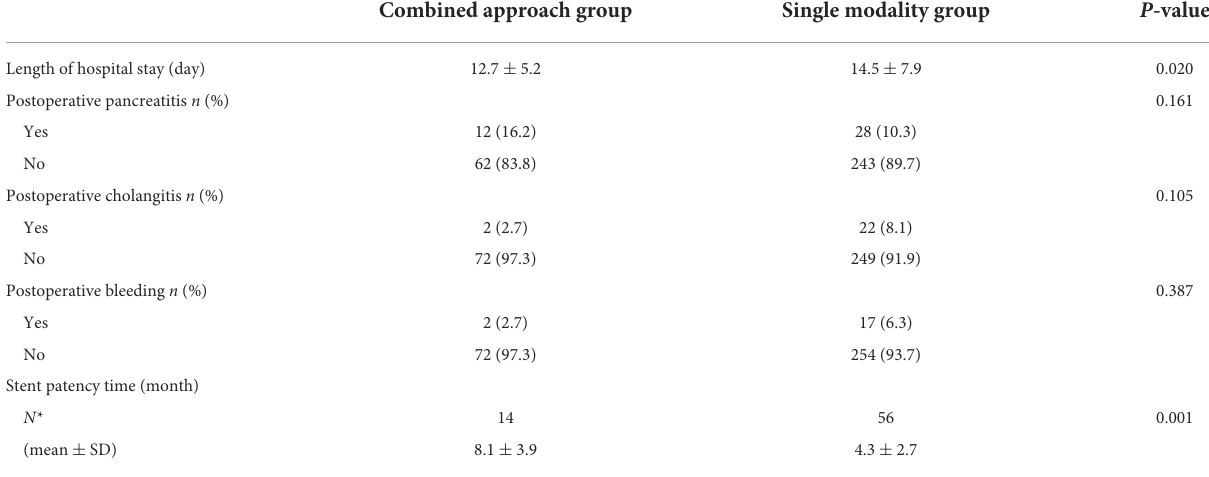
TABLE 5 Comparison of postoperative adverse events and efficacy in the two groups. Combined approach